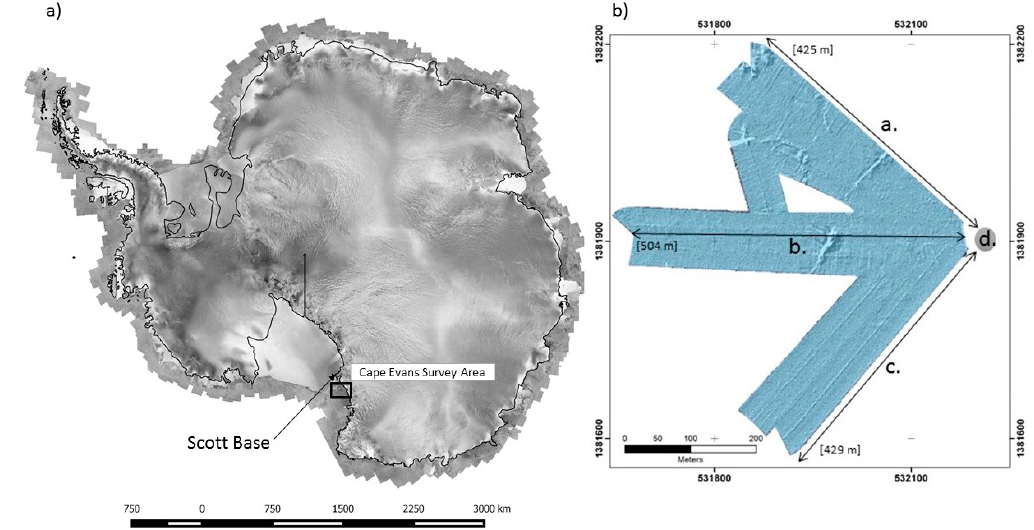
Figure 1. ( a ) Location of the autonomous underwater vehicle (AUV) survey site at Cape Evans, Antarctica; ( b ) length and configuration of the three primary AUV survey lines a/b/c and the deployment hole location d.